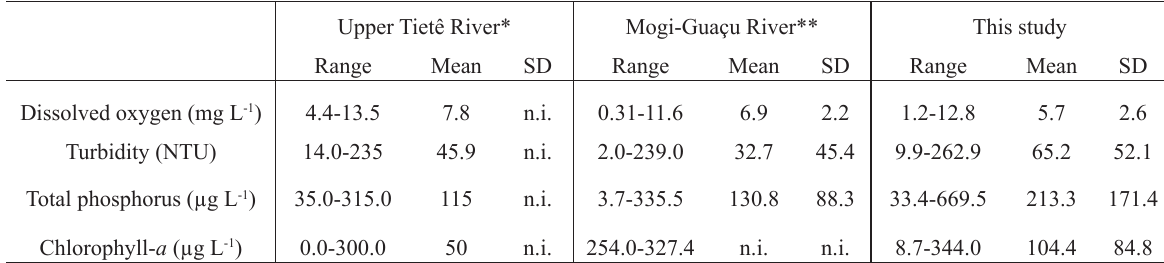
Comparison of the variables used to evaluate water quality in this study, with other similar studies in Brazil. * Sant´Anna et al. 2006, ** Eler and Espíndola 2006. n.i.=not